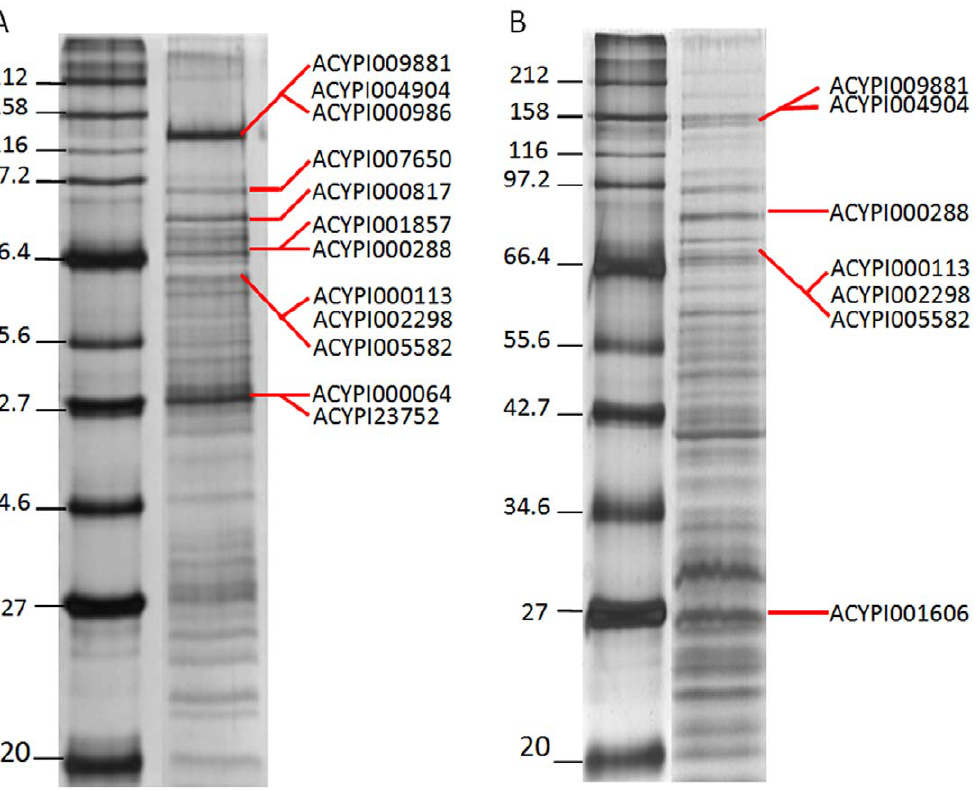
Figure 1. Fractionation of secreted salivary proteins by one-dimensional electrophoresis indicating bands from which proteins were identified by MS/MS and their subsequent protein hit/s (ACYPI numbers, see www.aphidbase.com ). A) Salivary proteins secreted by S. avenae ; 12 multiple peptide supported proteins were identified. B) Salivary proteins secreted by M. dirhodum ; 7 multiple peptide supported proteins were